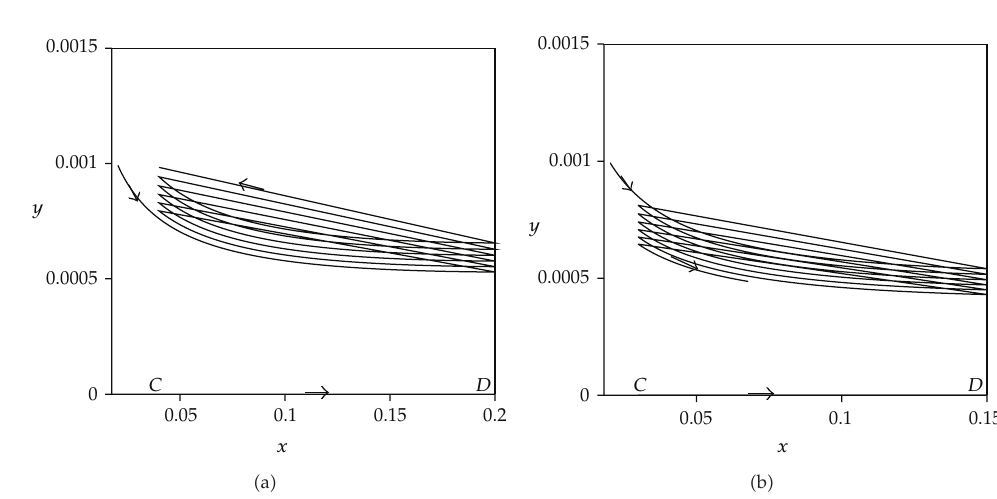
Figure 2: Trajectories with initial point (cid:7) 0.02, 0.001 (cid:8) of system (cid:7) 1.1 (cid:8) with p (cid:6) 0 . 8, q (cid:6) 0 . 5, τ (cid:6) 0: (cid:7) a (cid:8) h (cid:6) 0 . 2, (cid:7) b (cid:8) h (cid:6) 0 . 15.